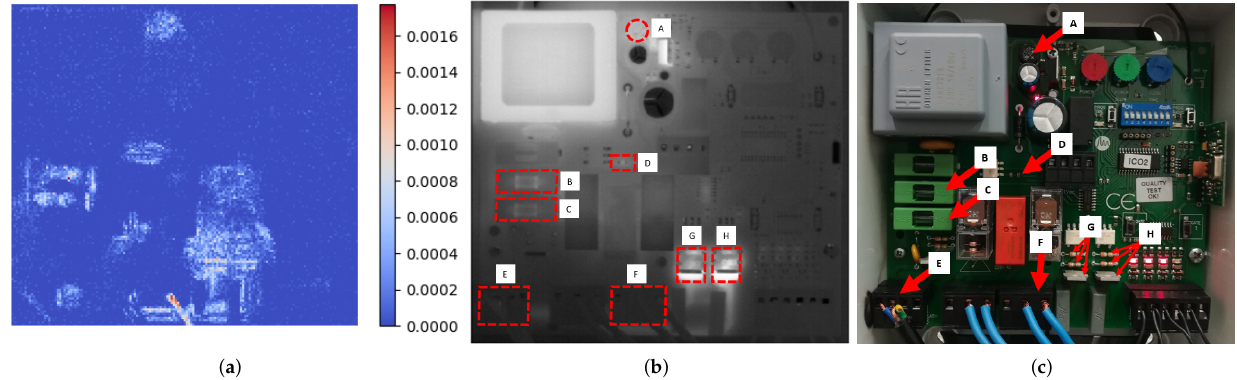
Figure 3. Identification of the regions of interest: ( a ) results of importance analysis; ( b ) location of the most informative regions; ( c ) identification of the corresponding electronic